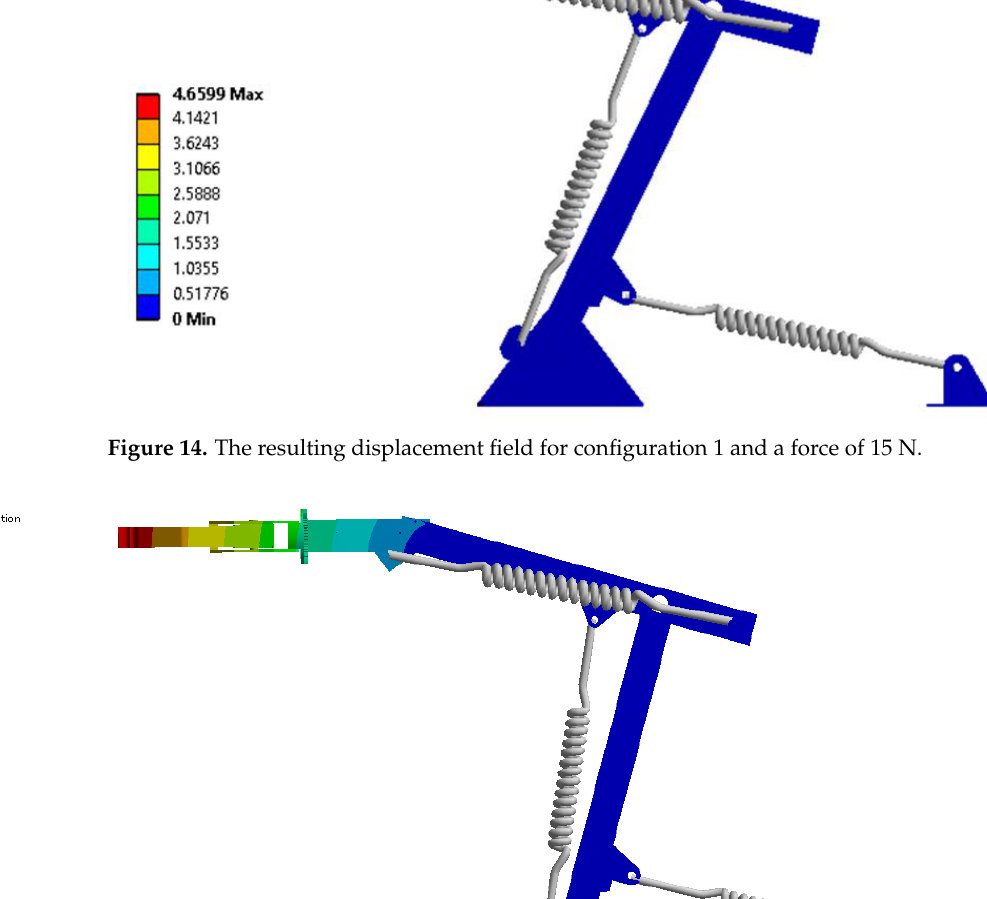
Figure 17. The resulting displacement field for configuration 4 and a force of 15 N.